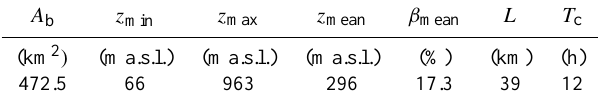
Table 1. Physiographic characteristics of the RMB including area ( A b ) , minimum ( z min ) , maximum ( z max ) and mean ( z mean ) el- evation, mean slope ( β mean ) , length of the main reach ( L) , and concentration time ( T c ) , computed using the Giandotti